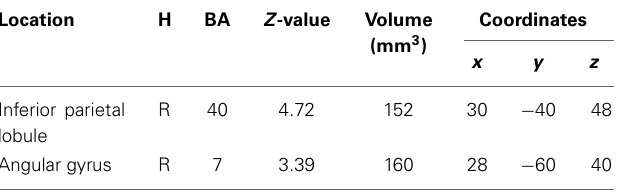
and lower signal intensity within the congenitally deaf individuals for the rhyming task.